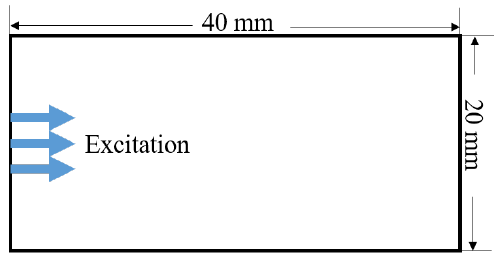
Figure 4. The 2D wave propagation model and the place of